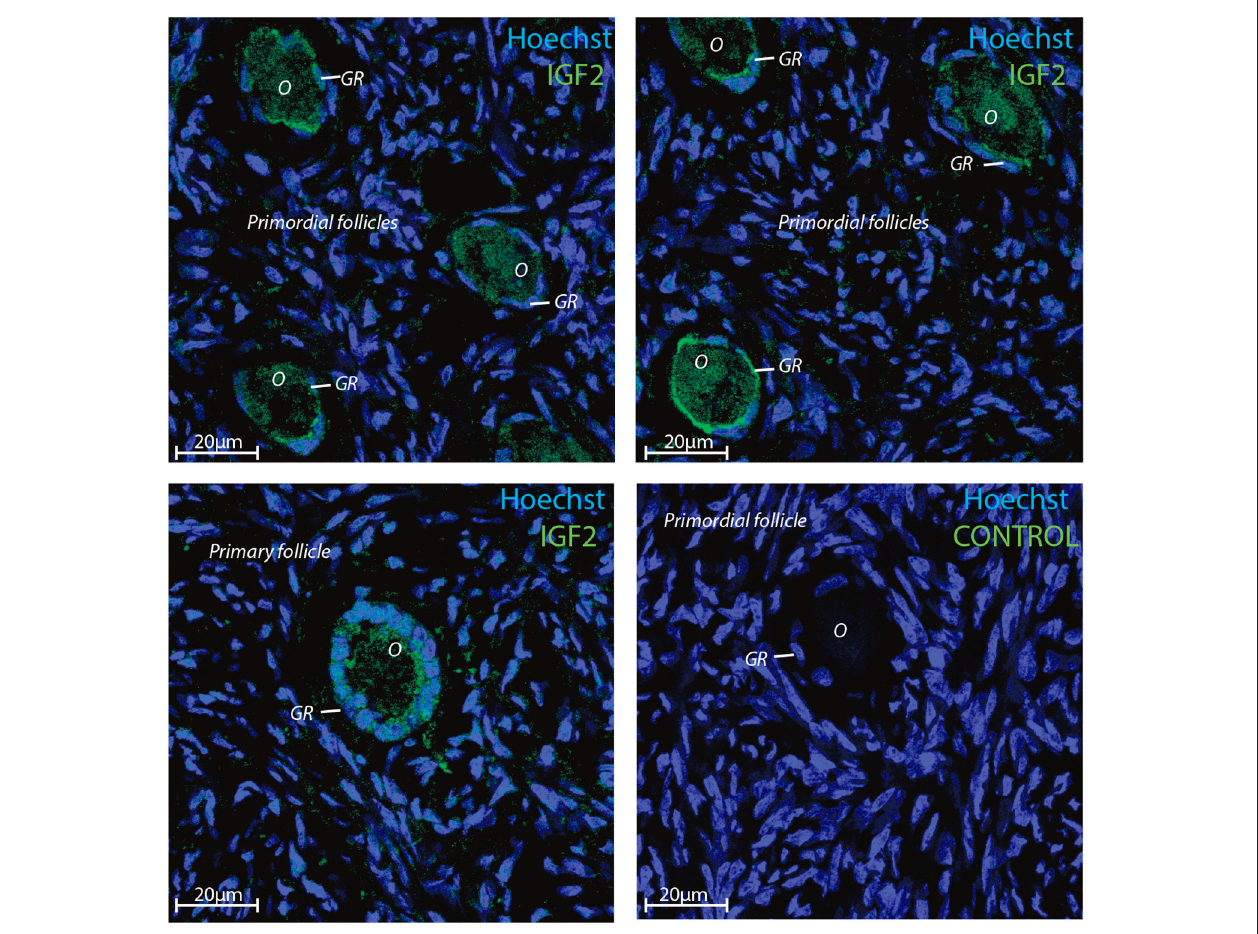
FIGURE 3 | Intra-ovarian distribution of IGF2 in human granulosa cells from primordial and primary follicles. Images show that IGF2 localized to oocytes and granulosa cells in primordial and primary follicles. A control without primary IGF2 antibody was included and reveals no staining. Hoechst staining identifies the nucleus of cells. Scale bars; 20 µ